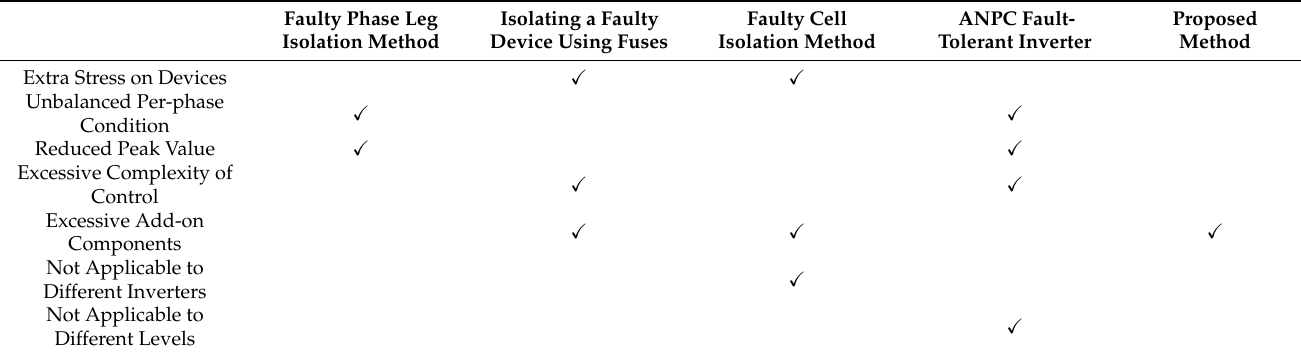
Table 6. Comparison of the proposed method with existing